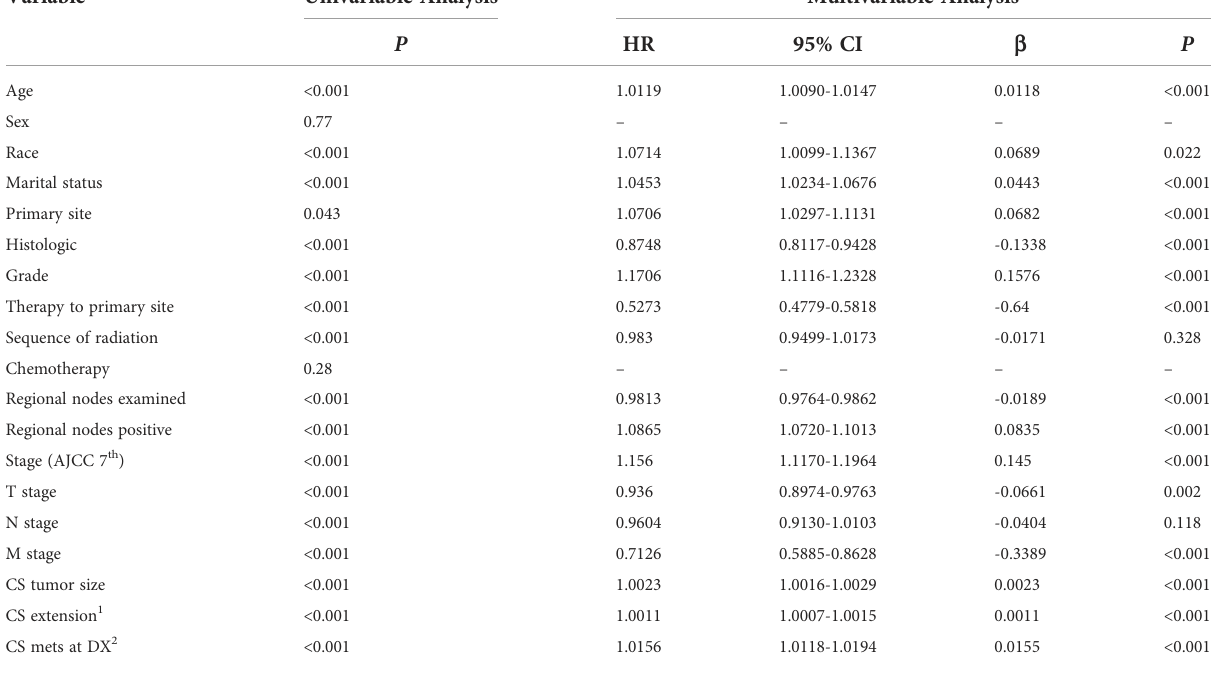
TABLE 2 The variables included in the Cox proportional hazard